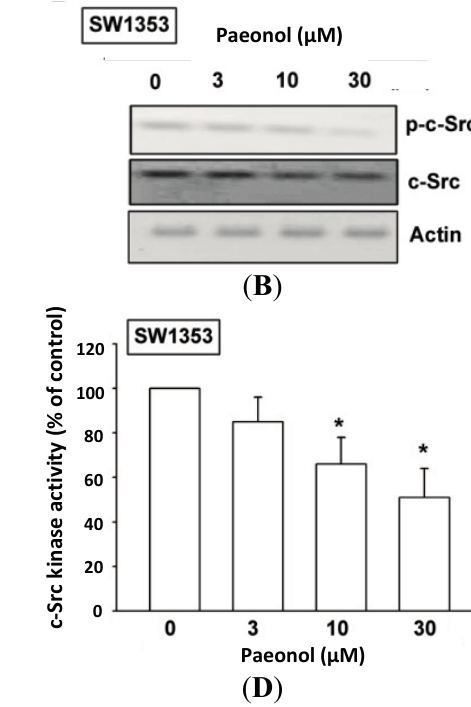
Figure 5. c-Src signaling pathway involved in paeonol response of chondrosarcoma. Cells were incubated with various paeonol concentrations for 24 h, c-Src kinase activity and phosphorylation examined by western blot ( n = 5) and c-Src kinase activity kit ( n = 5). Results are expressed as mean ± S.E.M. * , p < 0.05 compared with